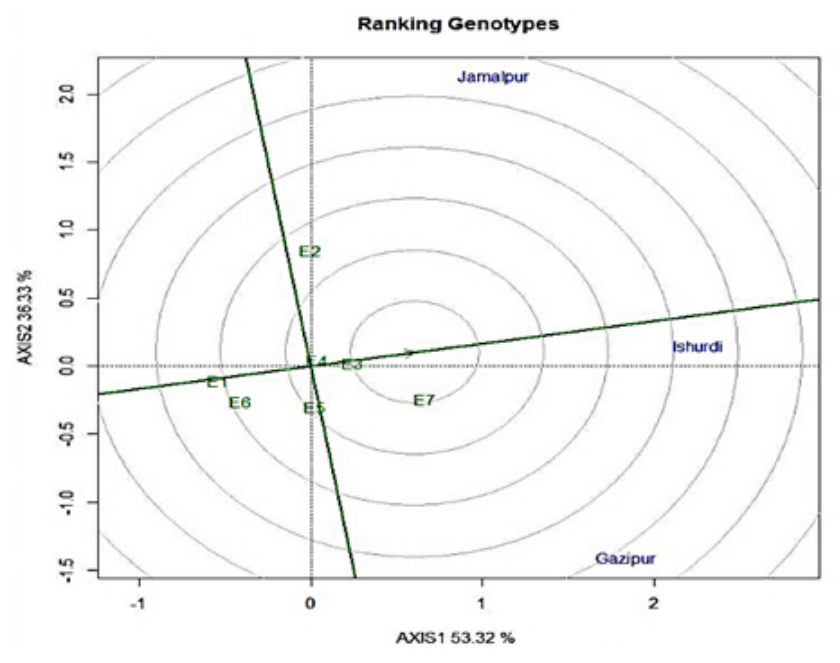
Figure 5: The average-environment coordination (AEC) view to rank genotypes relative to an ideal genotype (the center of the concentric circles)